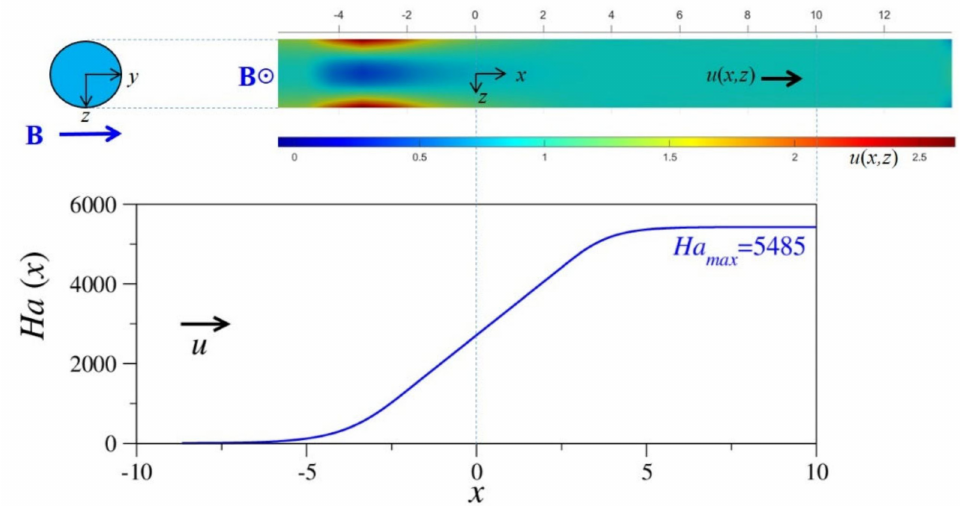
Figure 5. Pipe flow in an axially increasing magnetic field ( Ha = 5485 and Re = 10,043). Colored contours of axial velocity on the pipe symmetry plane, displayed in the upper plot, have been obtained from potential measurements at the electrically conducting